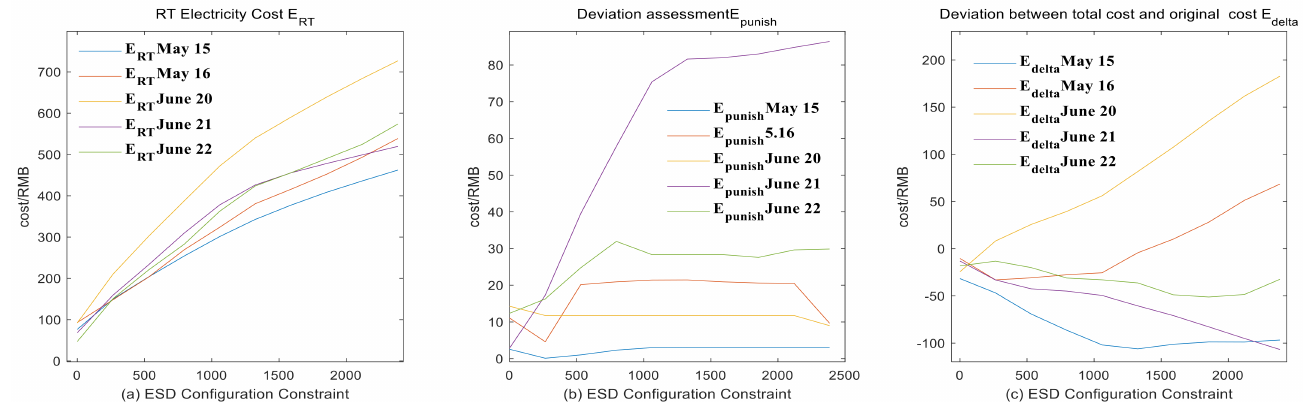
Figure 9. Trends of RT electricity cost, deviation assessment and total cost with DA optimization